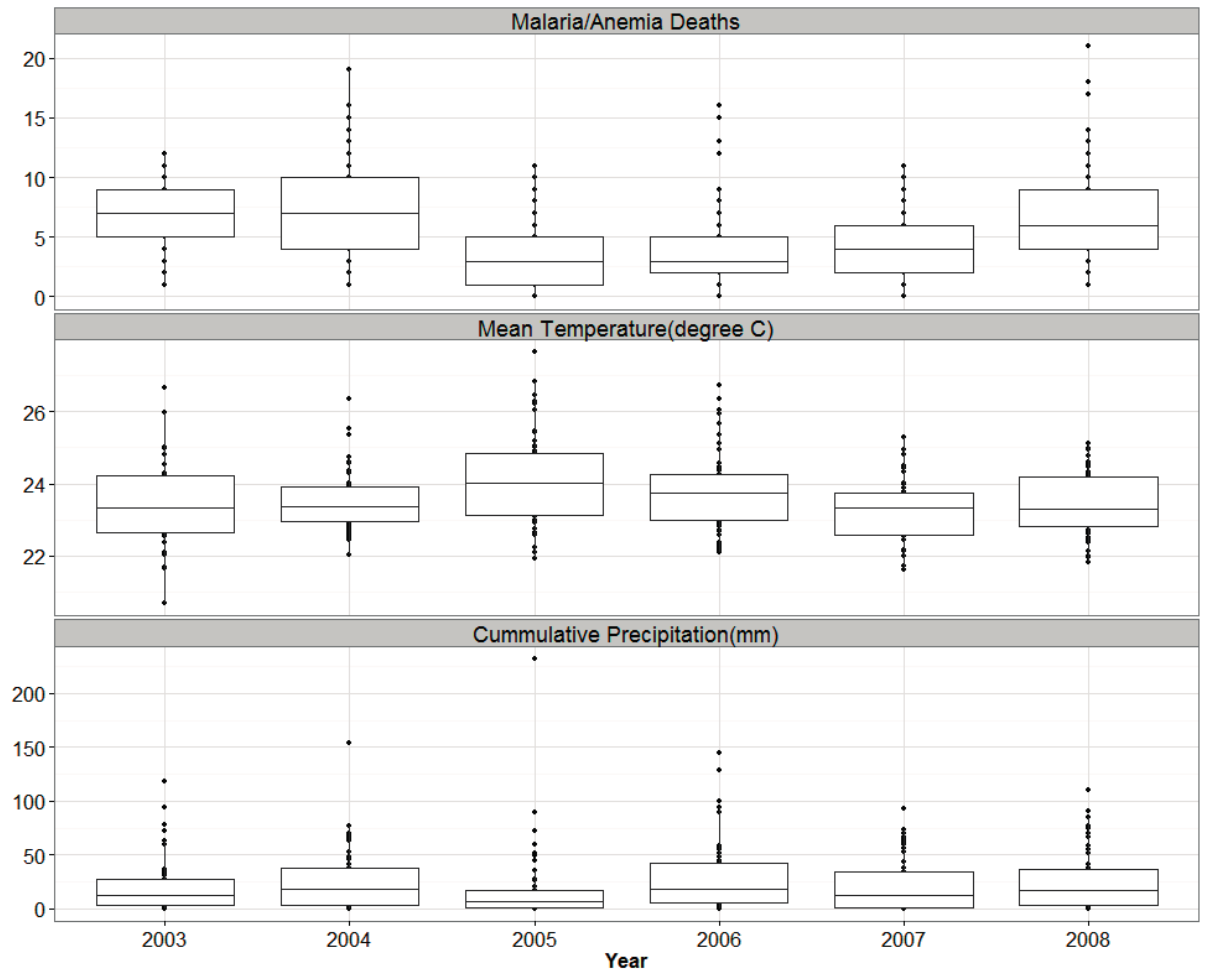
Figure 1. Boxplot of Weekly Malaria/Anemia Deaths among children under five years, Mean temperatures (°C) and cumulative precipitation (mm),